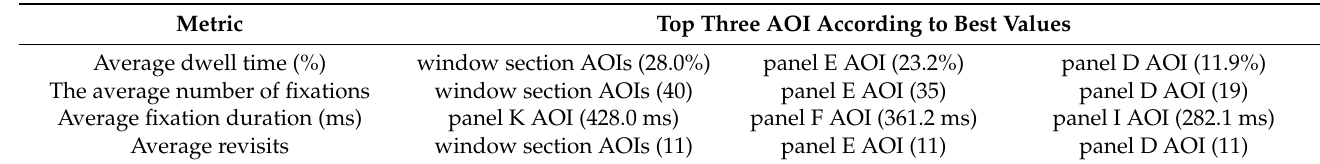
Table 8. The arrival procedure’s average statistic for railway stop